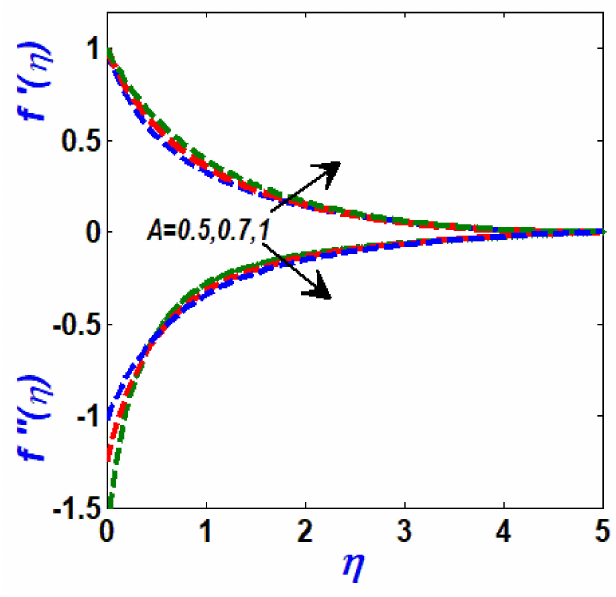
Figure 4. Velocity & acceleration profiles with variation in A .